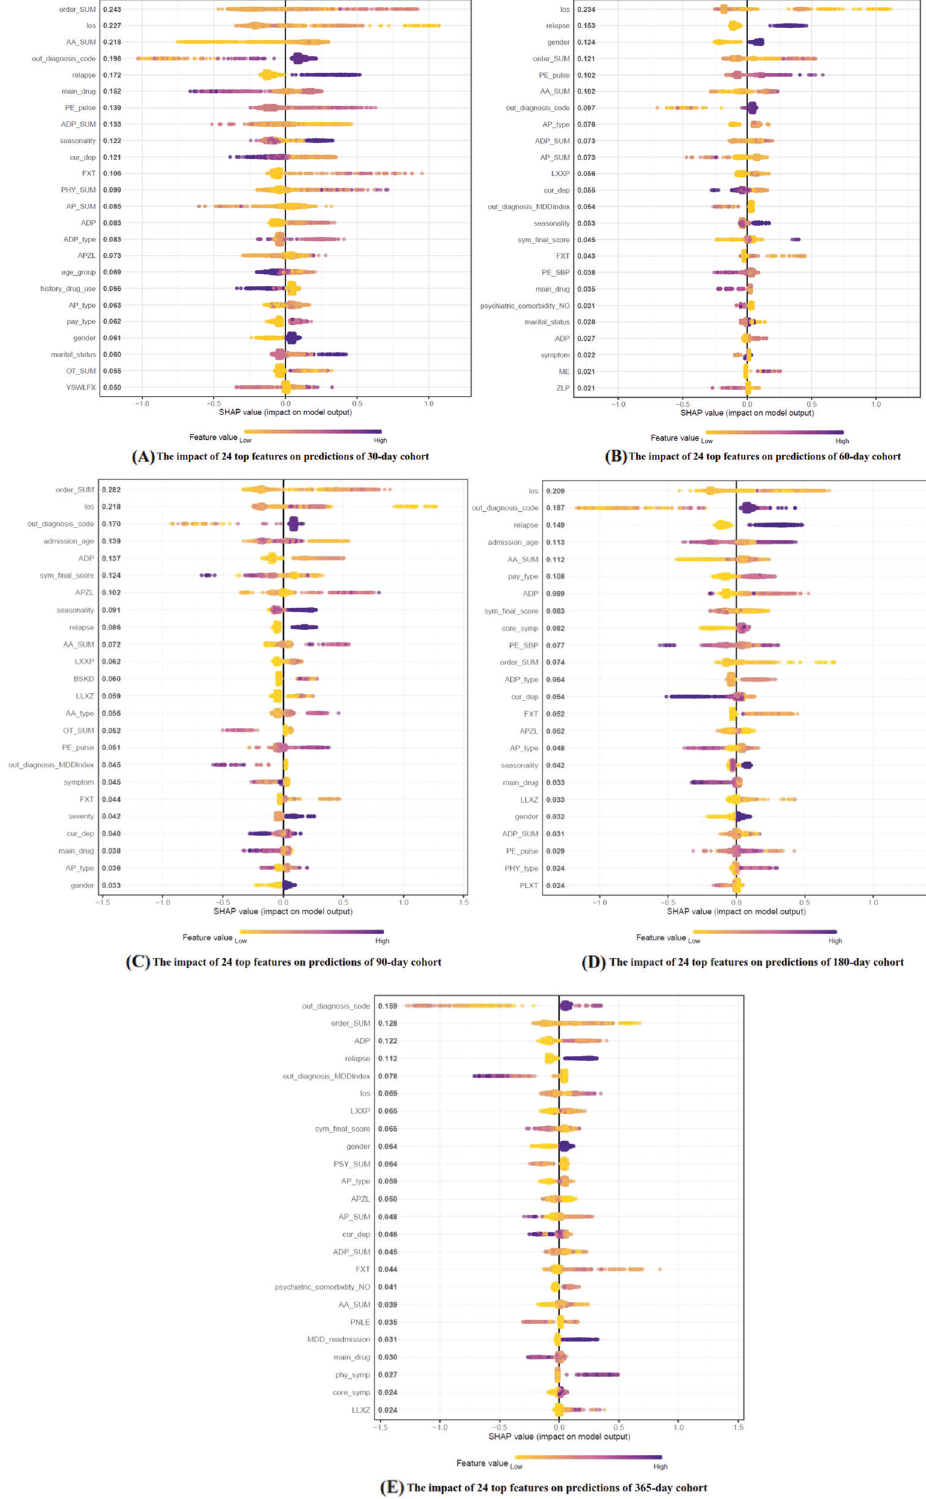
Fig. 5 The impact of the 24 top important features on predictions. A The impact of 24 top features on predictions of 30-day cohort. B The impact of 24 top features on predictions of 60-day cohort. C The impact of 24 top features on predictions of 90-day cohort. D The impact of 24 top features on predictions of 180-day cohort. E The impact of 24 top features on predictions of 365-day predictions after discharge of the initial major depression hospitalization, respectively. The current study is the fi rst of its kind to investigate the role of multiple predictors extracted from individual 30-, 60-, 90-, 180-, and 365-day psychiatric readmission